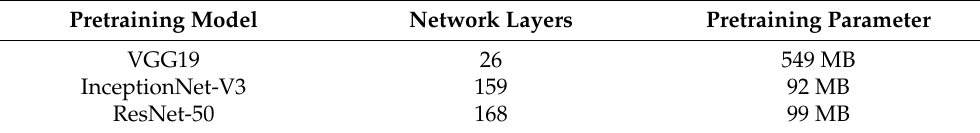
Table 1. Comparison of model and pretraining parameters.